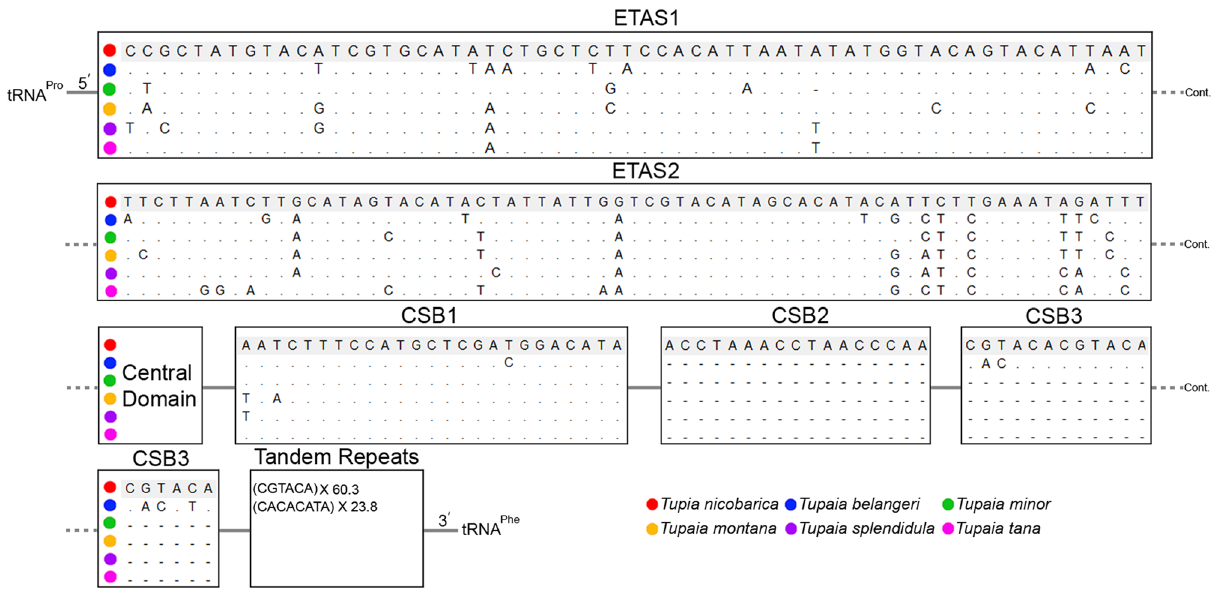
Figure 2. Comparison of nucleotide composition in different domains of control regions (CRs) and tandem repeats of six Tupaiidae species. The nucleotide compositions were compared through MEGAX software and the tandem repeats were predicted by the online Tandem Repeats Finder web tool (https:// tandem. bu. edu/ trf/ trf. html). The figure was edited manually in Adobe Photoshop CS